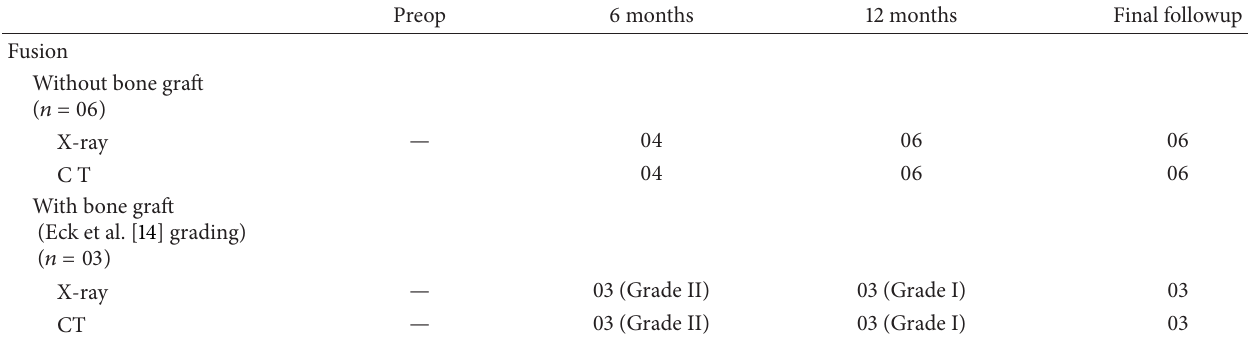
Table 2: Status of fusion in